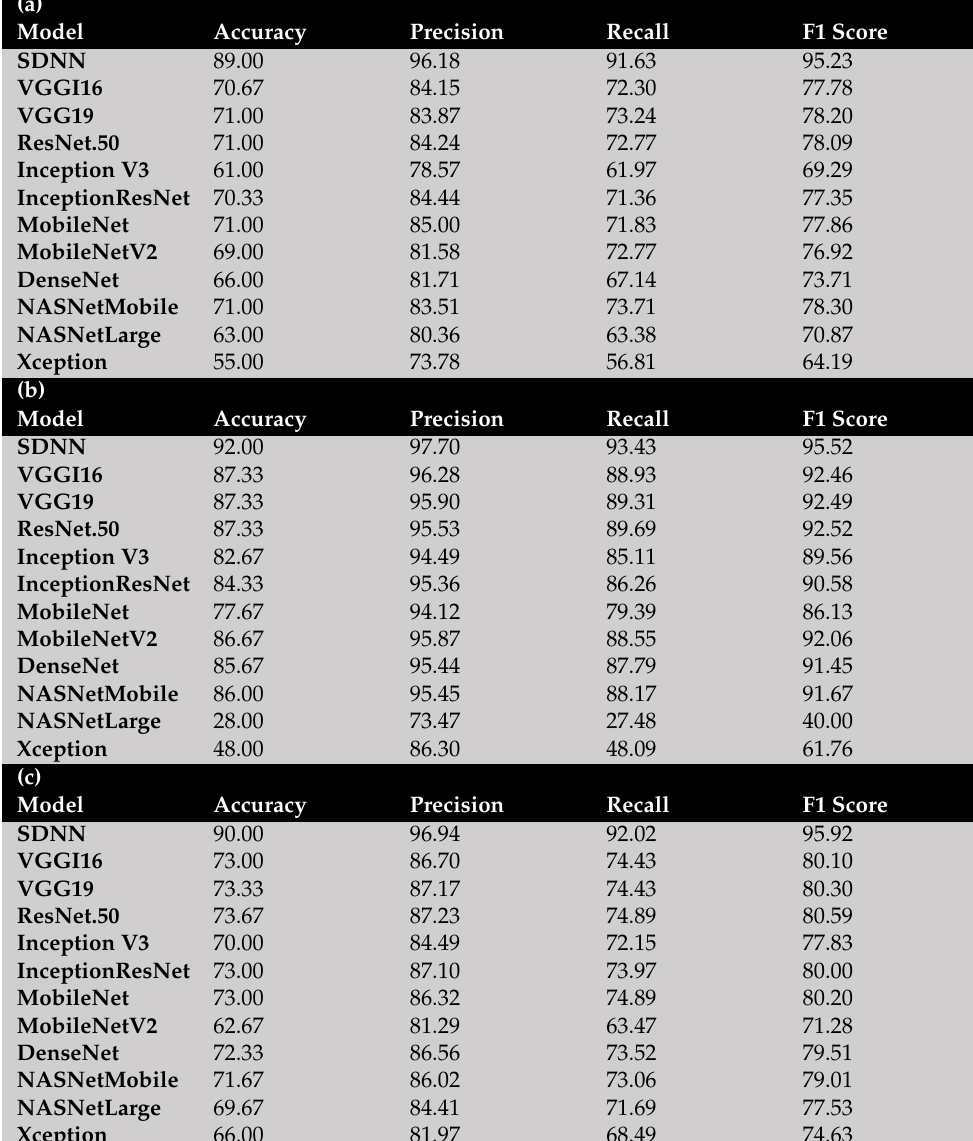
Table 6. (a) Comparison with modern deep-learning models for acrosome sperm cells. (b) Com- parison with modern deep-learning models for vacuole sperm cells. (c) Comparison with modern deep-learning models for head sperm cells.